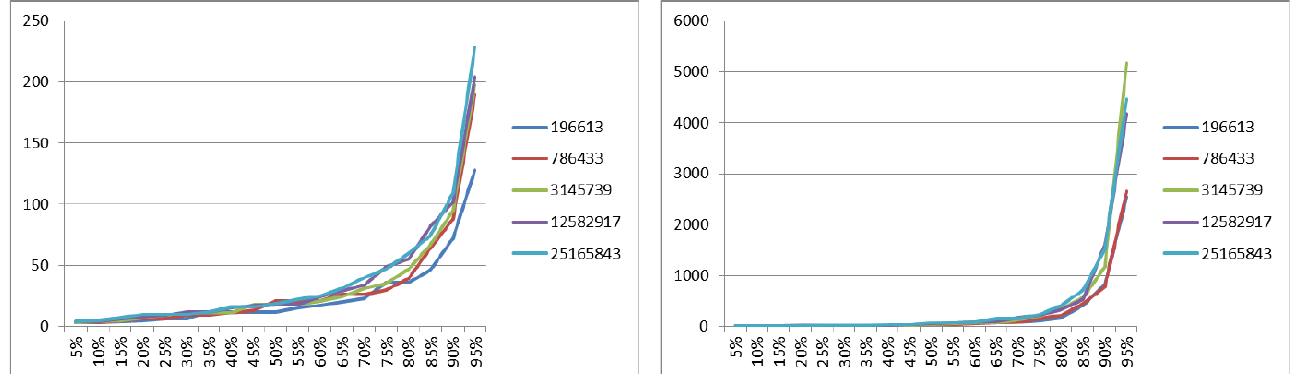
Fig. 8. Max collisions for Murmur, long jump, string length = 13